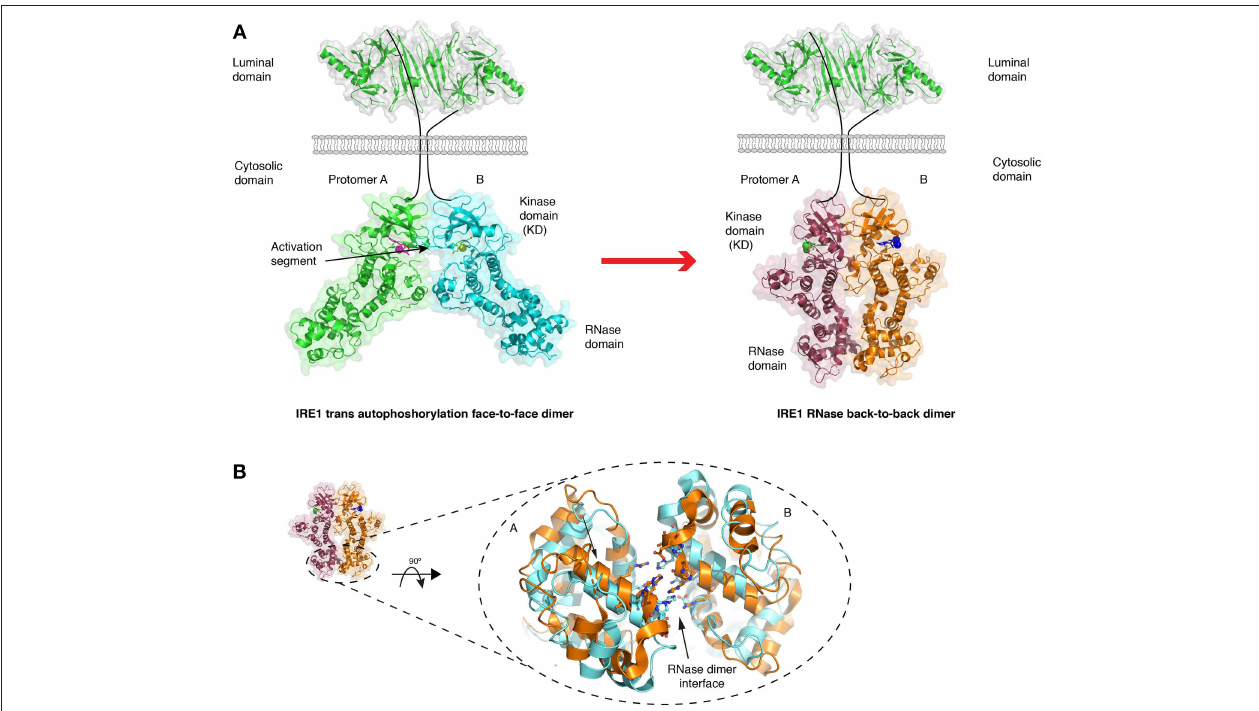
FIGURE 4 | Crystal structures of IRE1 cytosolic domain. (A) Schematic depicting the IRE1 cytosolic portion in a face-to-face dimer (PDB 3P23) that enables trans autophosphorylation, and in a back-to-back arrangement (PDB 2RIO), which is suggested to be the RNase active state. The red arrow represents the transition between these two states. (B) A comparison of crystal structures of IRE1 RNase domain when bound to a kinase inhibitor that prevents both kinase and RNase activation (gold, PDB 4YZ9) and when bound to a kinase inhibitor that activates RNase domain (cyan, PDB 4YZC). The small movements within the domain are suggested to enhance splicing